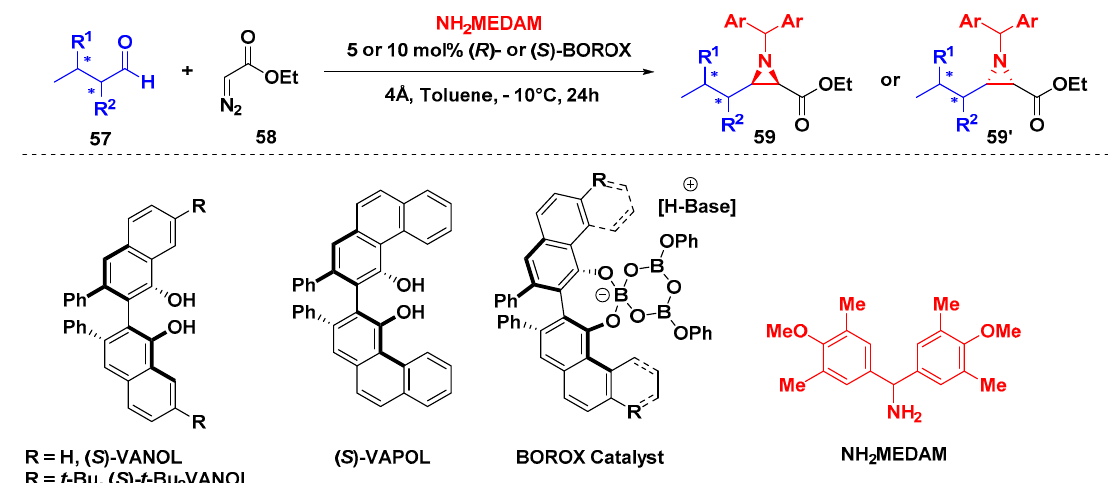
Molecules 2019 , 24 , x FOR PEER